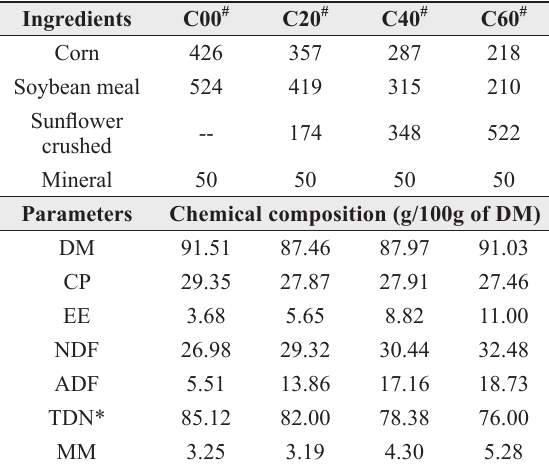
Share the ingredients (g/kg as fed) and chemical composition of concentrates (g/100 g Dry Matter -